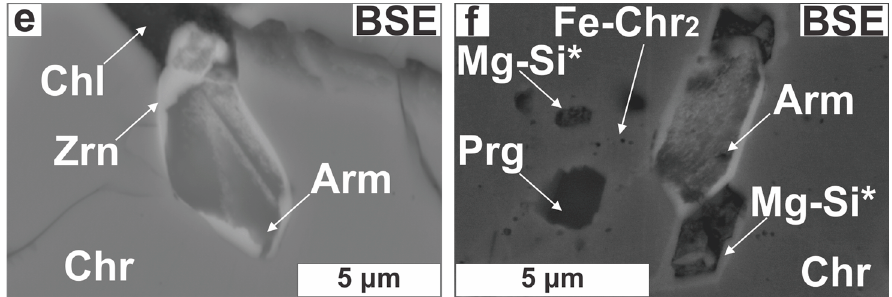
Figure 7. Photomicrographs illustrating the impact of alteration on zircons. ( a ) Subhedral, altered zircon in Cr-spinel; ( b ) Elongated zircon; ( c ) Intergrowth of zircon with calciocatapleiite; ( d – f ) Almost complete armstrongite for zircon substitution. Abbreviations (in order of appearance): Zrn* = altered zircon; Arm = armstrongite; Cpl = calciocatapleiite; Mg-Si* = unidentified Zr-bearing Mg-silicate; the rest as in Figures 4–6.